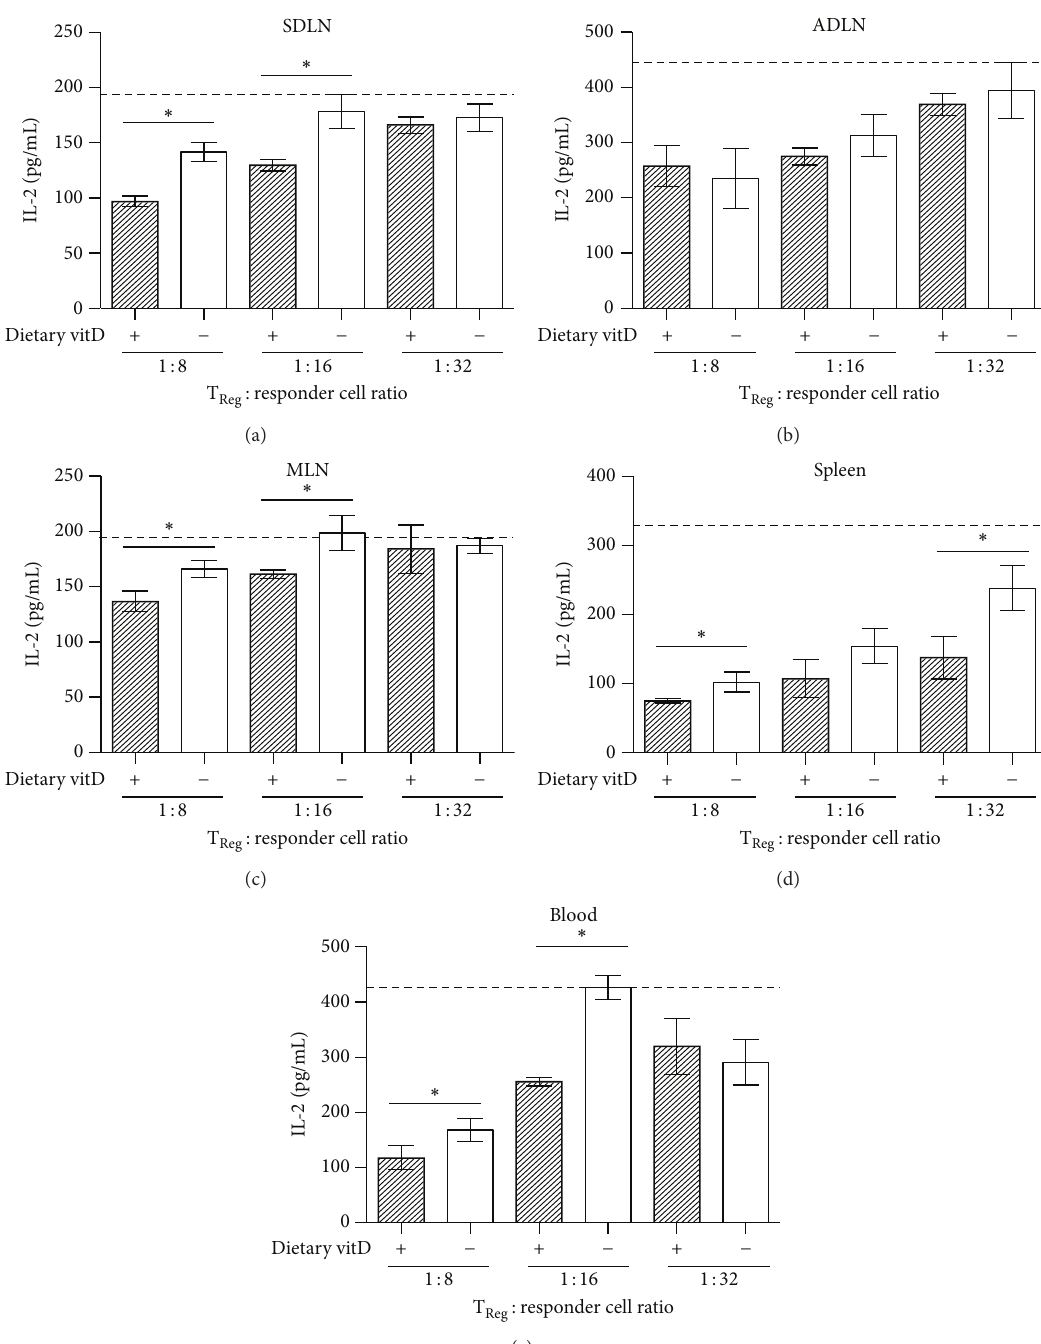
Figure 4: Dietary vitamin D enhanced the activity of Foxp3+ T cells at multiple immune sites. Female offspring born to vitamin D 3 - Reg (vitD-) replete (+) or vitamin D 3 -deficient ( − ) DO11.10 mothers were maintained on vitamin D-replete or vitamin D-deficient diets (resp.) until 8 weeks of age. CD4+CD25+(Foxp3+) cells were purified from (a) SDLN, (b) ADLN, (c) MLN, (d) spleens, or (e) blood of mice and cocultured with lymph node responder cells from DO11.10 mice at ratios of 1: 8, 1: 16, or 1:32 and OVA peptide. IL-2 levels in the coculture supernatants were measured after 96 h. The broken lines indicate the levels of IL-2 measured in supernatant of responder cells cultured with OVA peptide alone. Data are shown as mean ± SEM for 6 wells/treatment, representative of two experiments; ∗ 𝑝 < 0.05